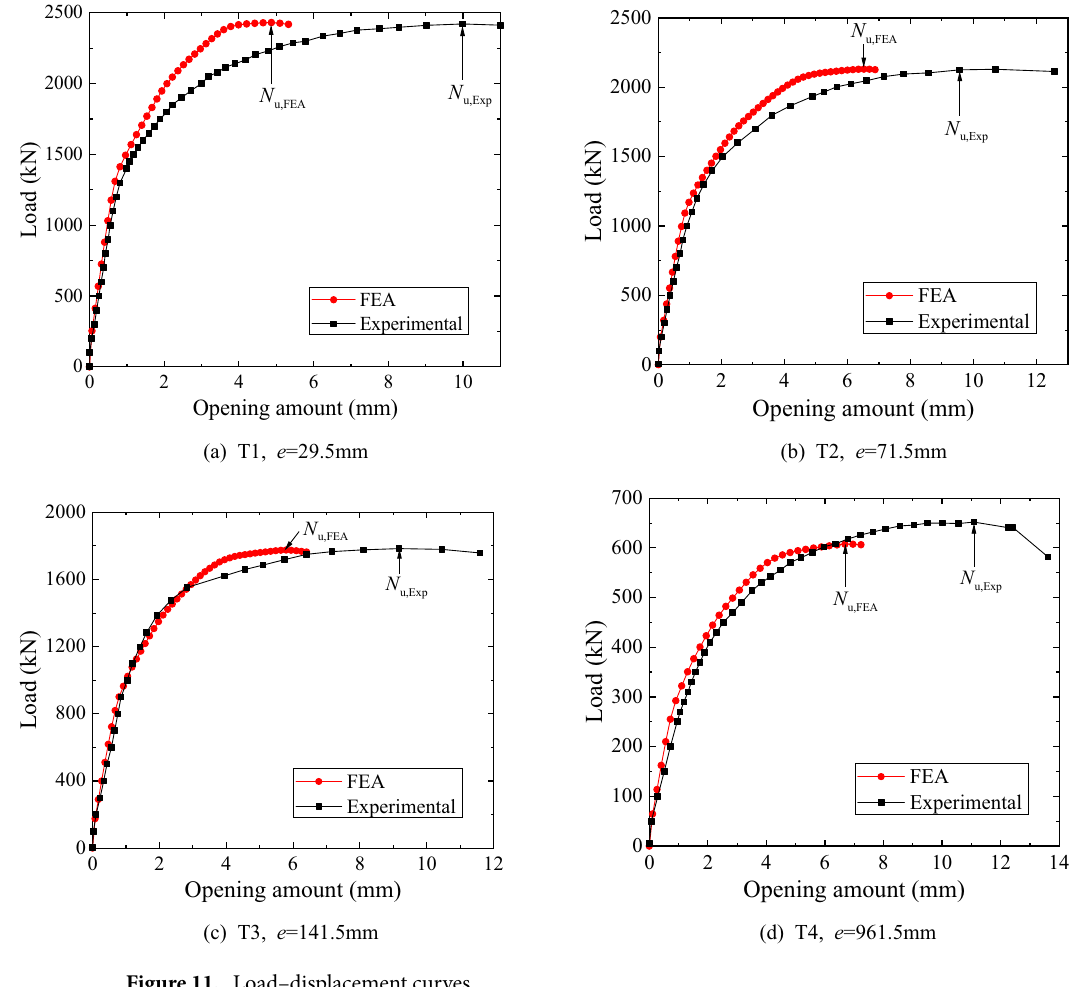
Figure 11. Load–displacement